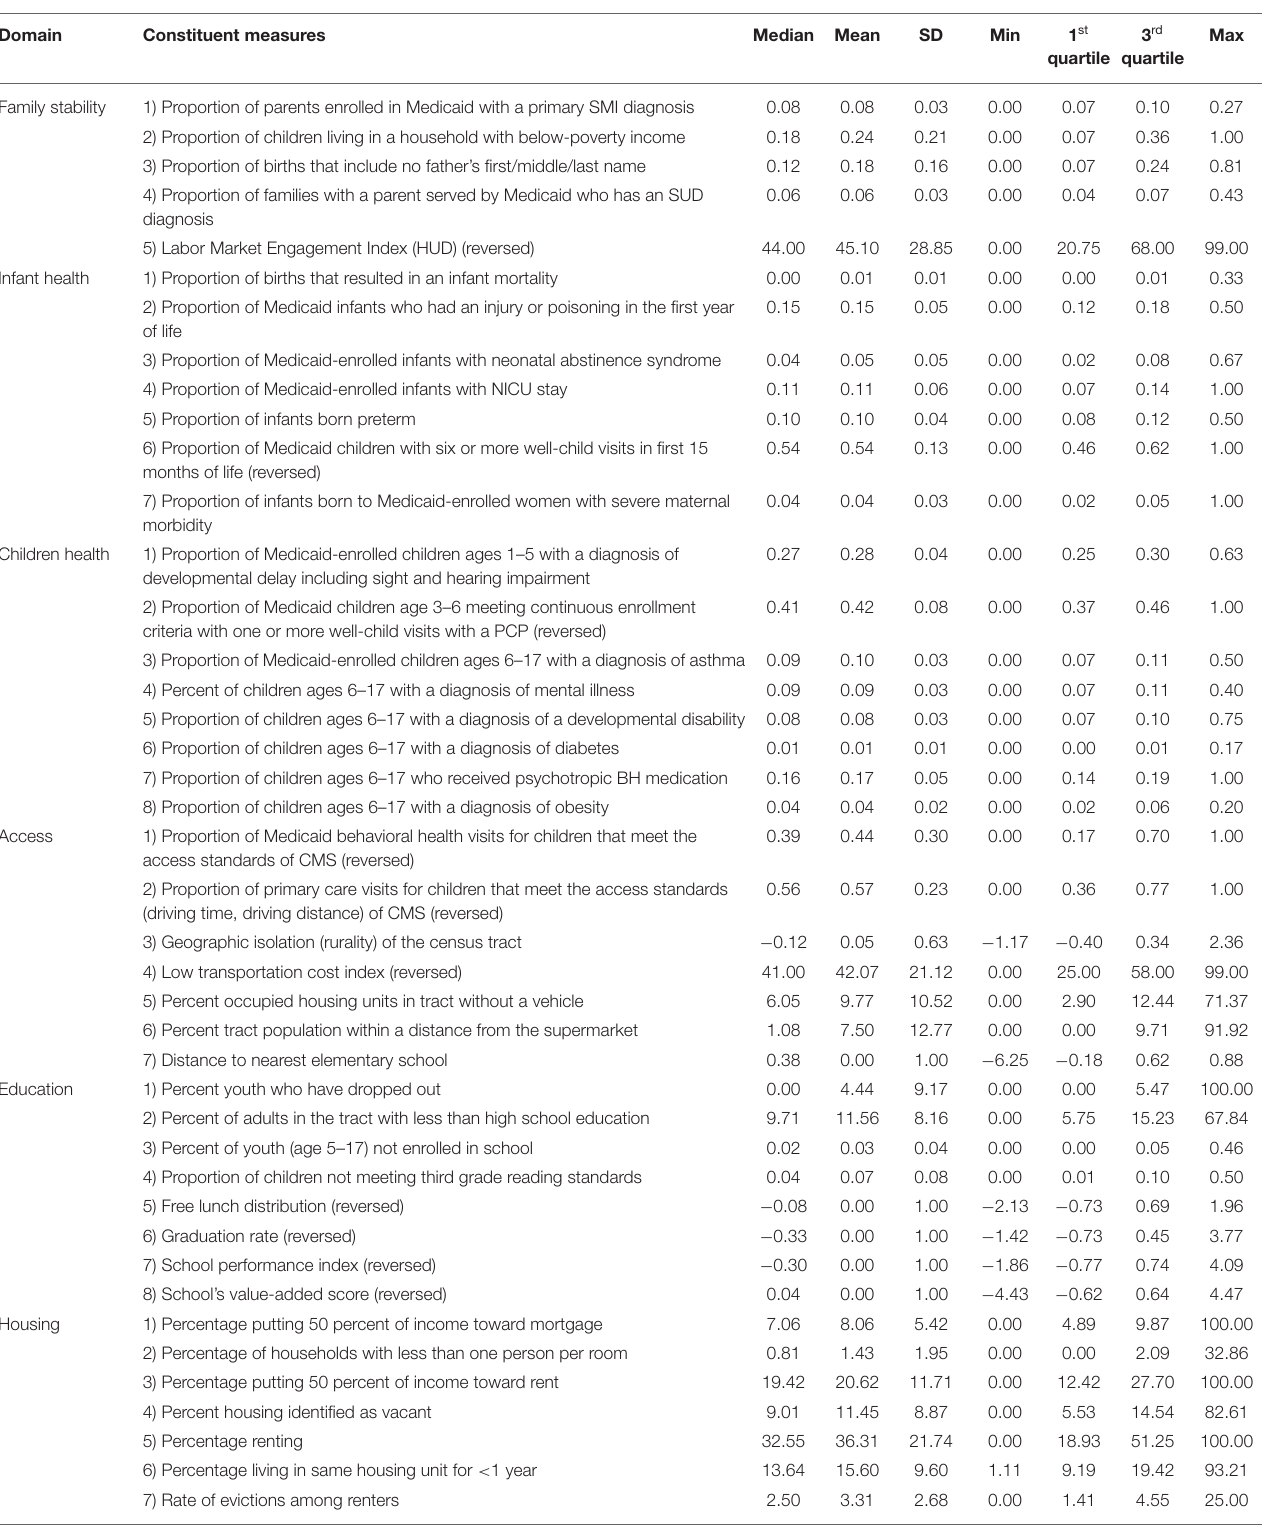
TABLE 1 | Univariate descriptive statistics of Ohio children’s opportunity index. Domain Constituent measures Median Mean